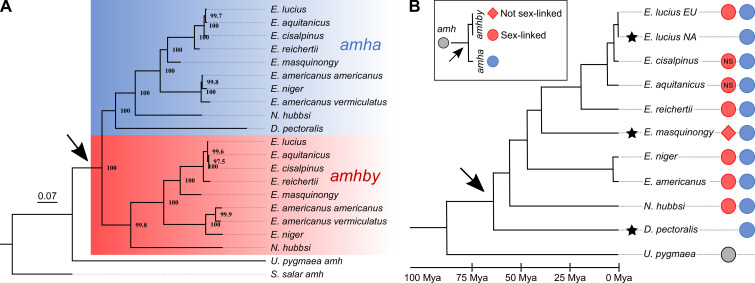
Phylogenetic analysis of amh homologs from the Esociformes revealed an ancient origin of amhby.(A) Phylogenetic tree of amh coding sequences built with the maximum-likelihood method. Bootstrap values are provided on each node of the tree. The amha ortholog cluster is highlighted with blue background and the amhby ortholog cluster is highlighted with red background. (B) Time-calibrated species phylogeny of the Esociformes (Campbell et al., 2013). The three putative SD transitions are shown by black stars. The presence of pre-duplication amh, as well as amha and amhby along with the amhby sex linkage, is represented by colored dots at the end of each branch. In E. cisalpinus and E. aquitanicus, sex linkage is not significant (NS) due to low sample size. The earliest duplication timing of amh is denoted by a black arrow at the root of the divergence of Esocidae.